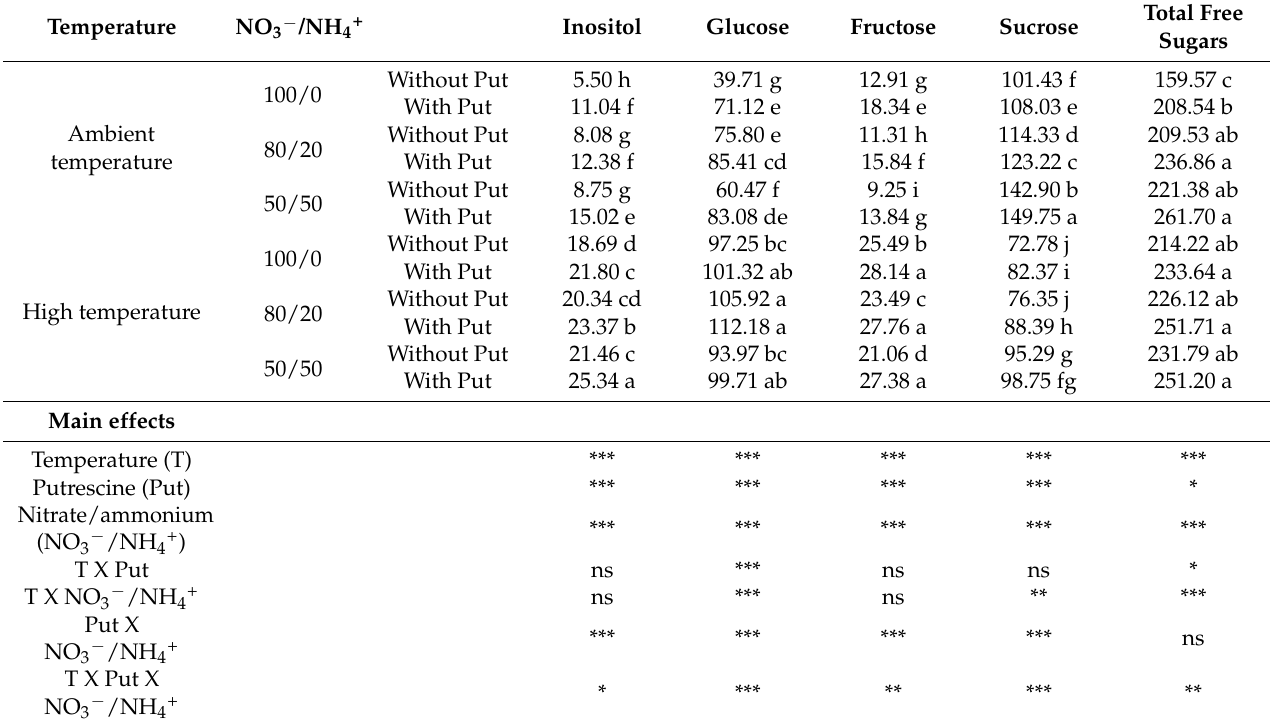
Table 2. Effect of the foliar application of putrescine on the concentrations of sugars (g kg − 1 DW) in outer leaves of the cauliflower cv. Moonshine at different NO 3 − /NH 4+ ratios and